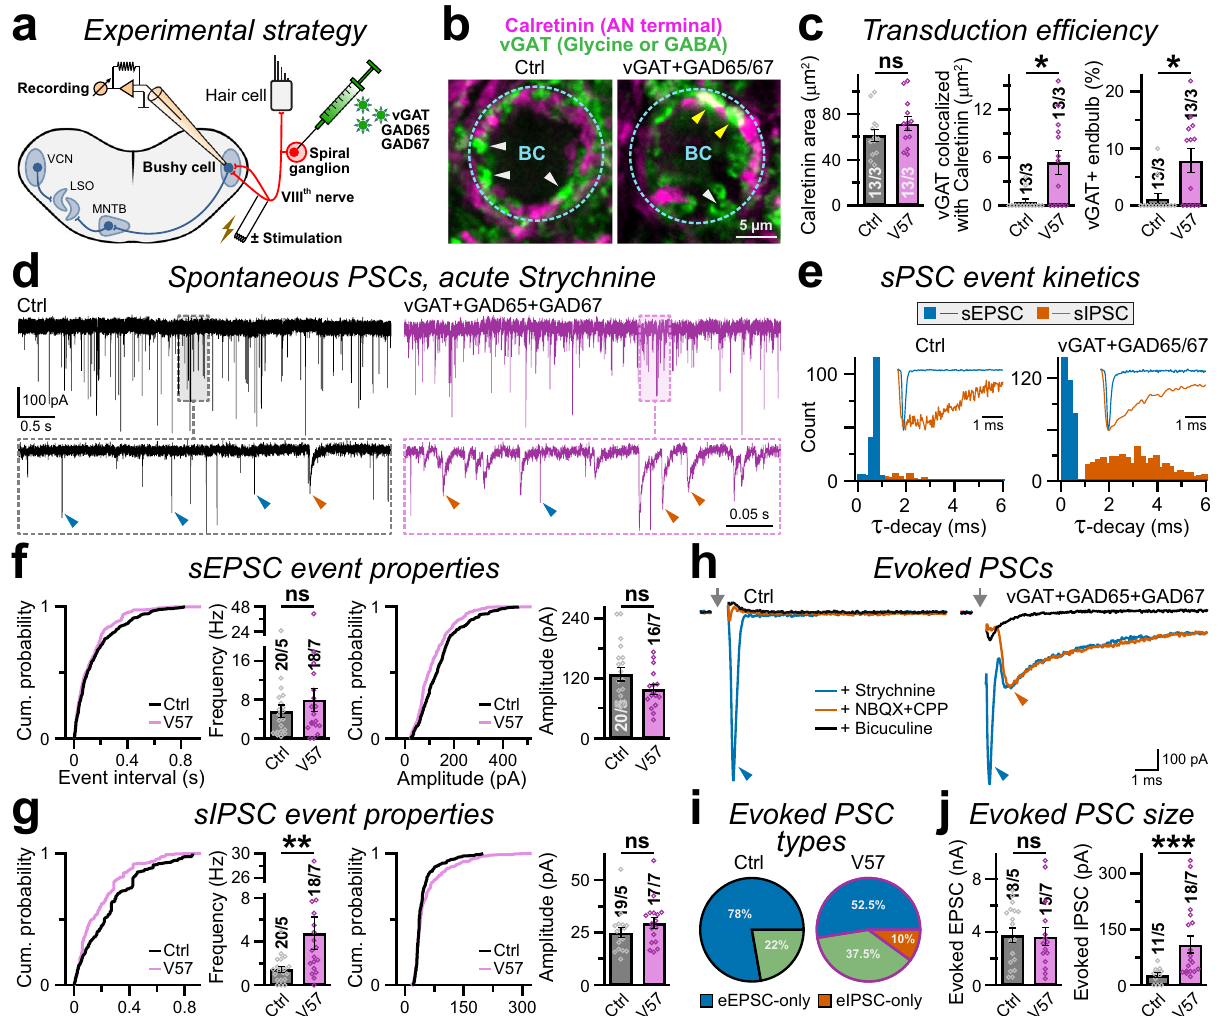
Fig. 7 V57 factors generate functional GABAergic synapses in vivo. a Schematic diagram depicts experimental strategy to manipulate the transmitter identity of endbulb synapse. b Representative images of BC somas (cyan circles) surrounded by Calretinin and vGAT -positive presynaptic terminals, in control (left) vs. V57-injected (right) animals. The vGAT signals often overlapped with Calretinin-positive endbulb terminals in V57 condition (yellow arrows), but minimally for control condition (white arrows). c Average size of AN-terminals measured using Calretinin signals (left), endbulb area co- occupied by vGAT signal (middle), and fraction of endbulbs co-expressing vGAT (right), presumably induced by the V57 factors. d , e Sample traces d and frequency distribution of τ -decays e of sEPSCs (blue arrowheads and histogram) and sIPSCs (red arrowheads and histogram) recorded from control (left) vs. V57 (right) conditions. Insets in e , sample sEPSC and sIPSC traces scaled and superimposed to compare their event kinetics. All recordings were performed in the presence of 1 µ M Strychnine to suppress sIPSCs from local glycinergic inputs. f , g Cumulative probability plots and average bar-graphs of event frequency (left) and amplitudes (right), for AMPAR-mediated sEPSCs f or GABA A R-mediated sIPSCs g . h Example traces of evoked PSCs (stimulus artifacts replaced by grey arrows), recorded from control (left) vs. V57 (right) condition, after acute treatment of 1 µ M Strychnine (blue traces), or following the additions of 10 µ M NBQX + 5 µ M CPP (red traces), and 20 µ M Bicuculline (black traces). Arrowheads, EPSC (blue) or IPSC (red). i Pie-charts represent fraction of cells with indicated PSC types (either EPSC-only, or IPSC-only, or both). j Amplitudes of evoked EPSCs (left) and IPSCs (right), averaged from neurons with successful responses. Averages indicate mean ± SEM, with total number of fi eld-of-views analyzed (for imaging) or neurons patched (for patch-clamp recording) / number of injected animals, and individual data-points (color-coded open circles). Statistical signi fi cance was tested by two-tailed, unpaired, Student ’ s t-test (near normally distributed results), or two-sided, nonparametric Mann-Whitney U-test, with *** P < 0.005; ** P < 0.01; * P < 0.05; ns = not signi fi cant, P >